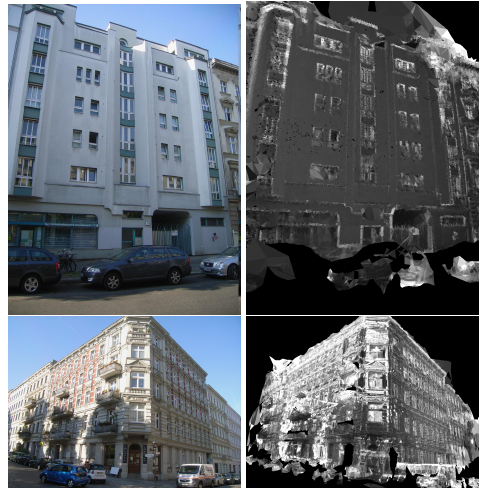
Figure 8. Two fac¸ade images and the corresponding colour dif- ference images over the complete sequence.